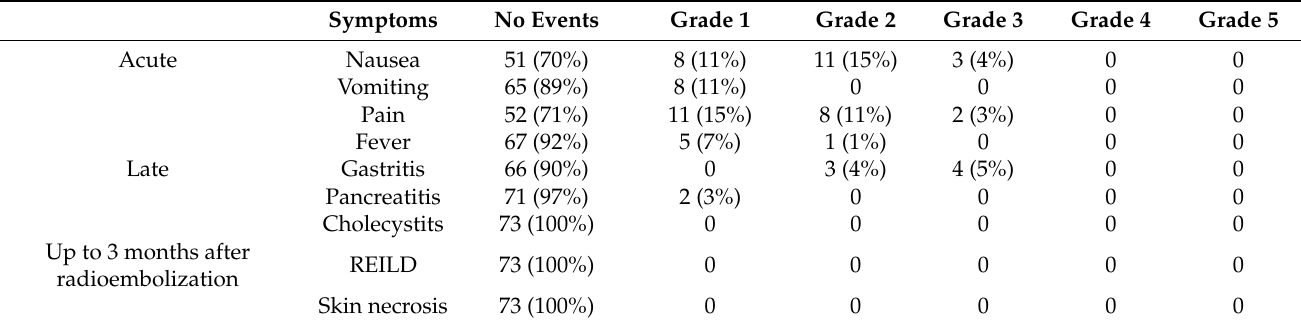
Table 5. Adverse event acute and late